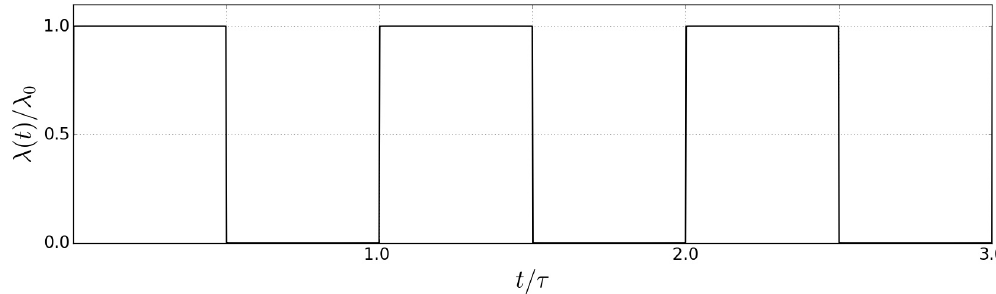
Figure 3. The on-off pulse evolution of λ ( t ) / λ 0 given by Equation